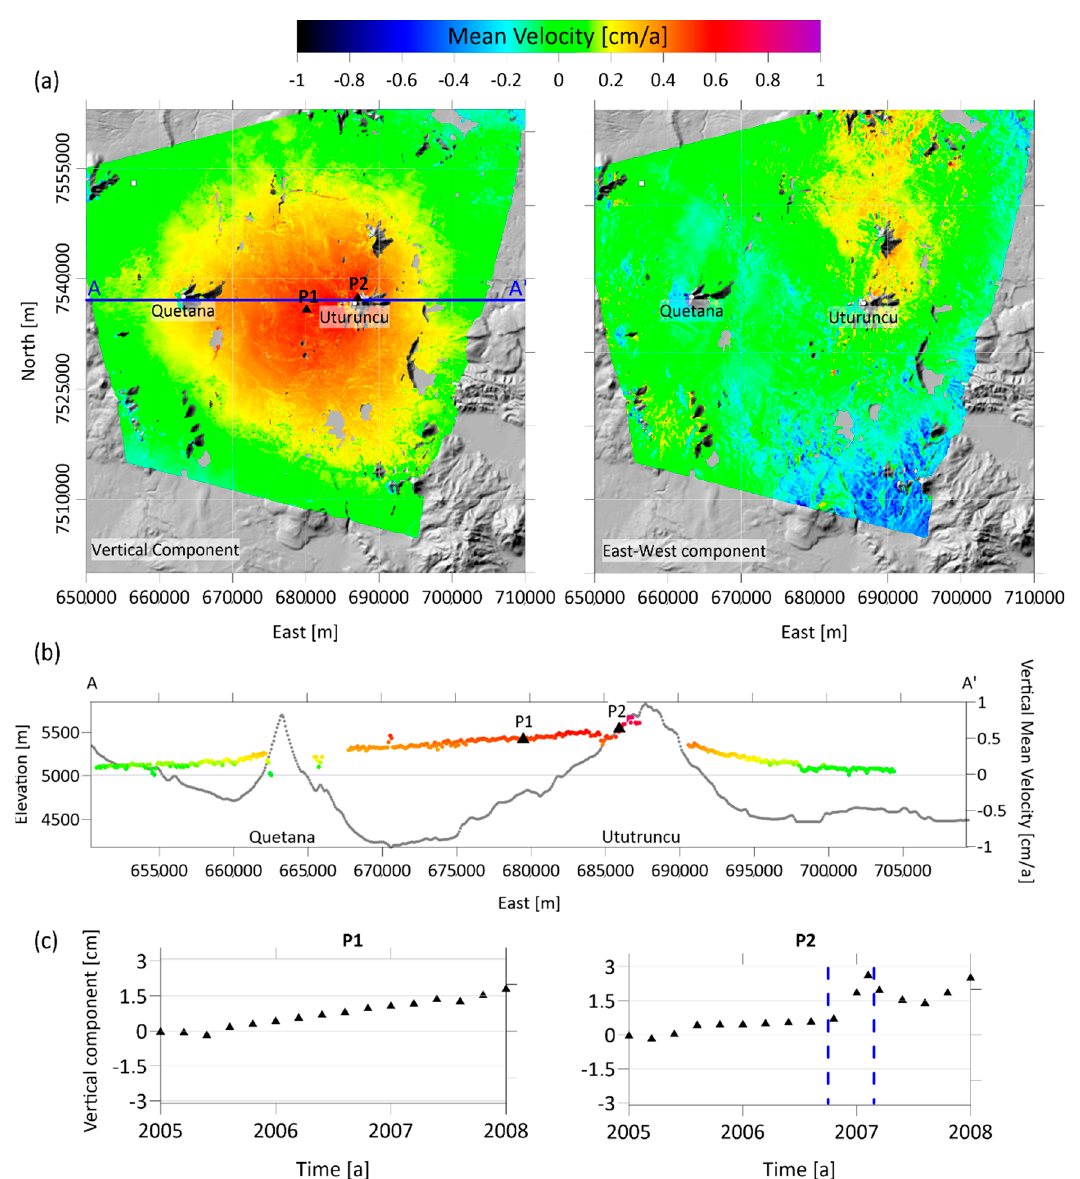
Figure 2. Vertical and East-West deformations at APVC and Uturuncu volcano. ( a ) Mean velocity maps (cm/a) of vertical (left) and East-West (right) components, superimposed on the SRTM DEM; the white solid square shows the reference point, the white solid circles indicate the Uturuncu and Quetana volcanoes location, the solid black triangles show the location of the P1 and P2 pixels, while the blue continuous line represents the AA’ trace; ( b ) AA’ profile of the vertical mean velocity (colored solid circles) and of the topography (grey solid circles); the black solid triangles represent P1 and P2 pixels on the AA’ profile; ( c ) Vertical displacement time-series at the pixels P1 (left) and P2 (right) related to the analyzed 2005–2008 interval; the blue dashed lines indicate the time interval in which a higher uplift rate is